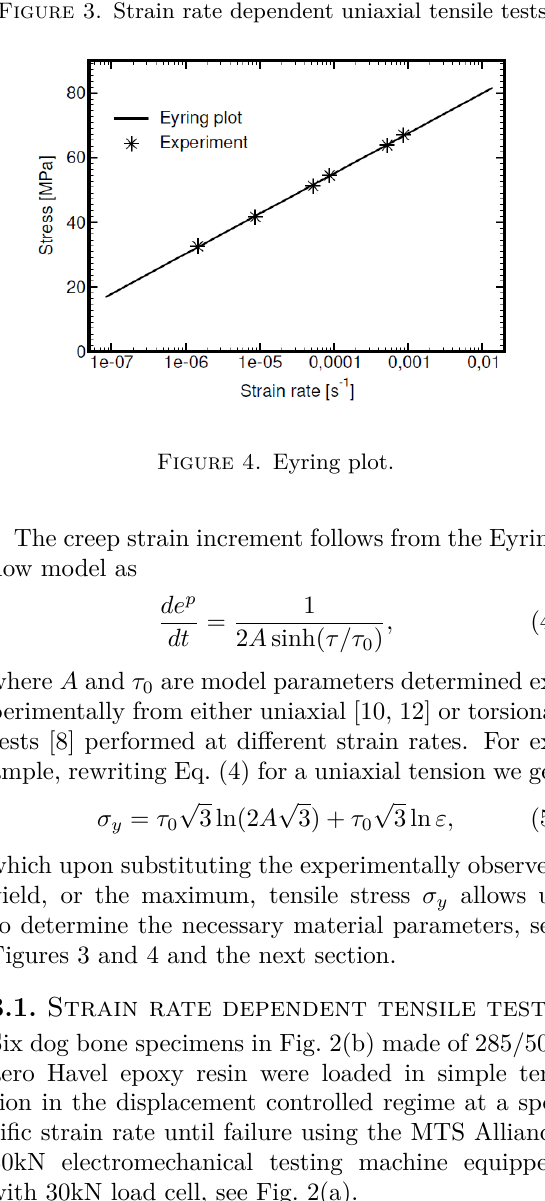
Figure 3. Strain rate dependent uniaxial tensile tests.